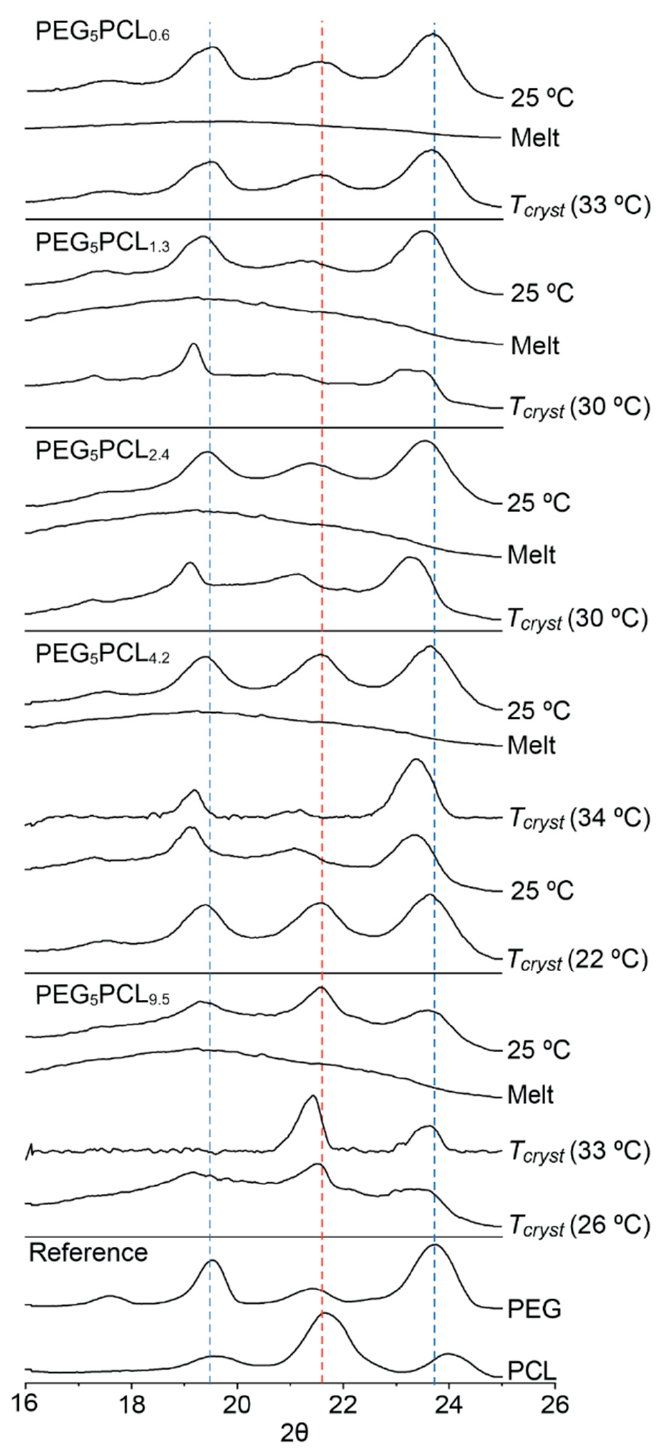
Figure 6. Stacked WXRD diffraction patterns of the PEG 5 and PCL 2 homopolymers recorded at 25 °C, and the PEG 5 PCL y copolymer series at room temperature (25 °C), in the molten state (80 °C) and at the T cryst values upon cooling.